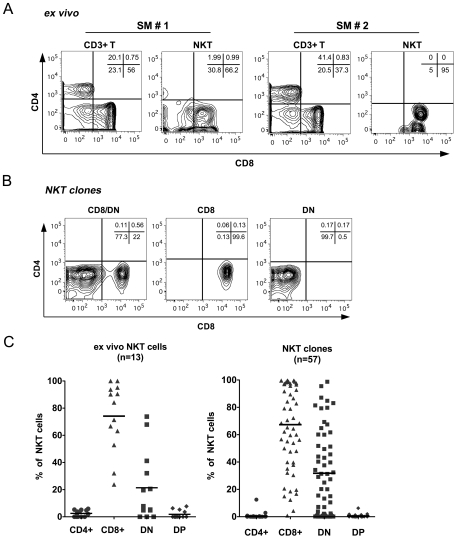
T lymphocyte subset distribution of sooty mangabey NKT lymphocytes.A) Representative contour plots showing surface expression of CD4 and CD8 molecules on ex vivo circulating T and Vα24+CD1d TM+ NKT lymphocytes in two sooty mangabeys (SM #1 and SM #2). B) Contour plots showing surface expression pattern of CD4 and CD8 molecules on representative NKT clones. C) Distribution of CD4+ (CD4+8−), CD8+ (CD8+4−), DN (CD4−8−) and DP (CD4+8+) T lymphocyte subsets in ex vivo NKT lymphocytes in 13 SIV-negative sooty mangabeys (left panel) and in 57 NKT clones derived from sorted 6B11+ T lymphocytes of one SIV-negative sooty mangabey (right panel).